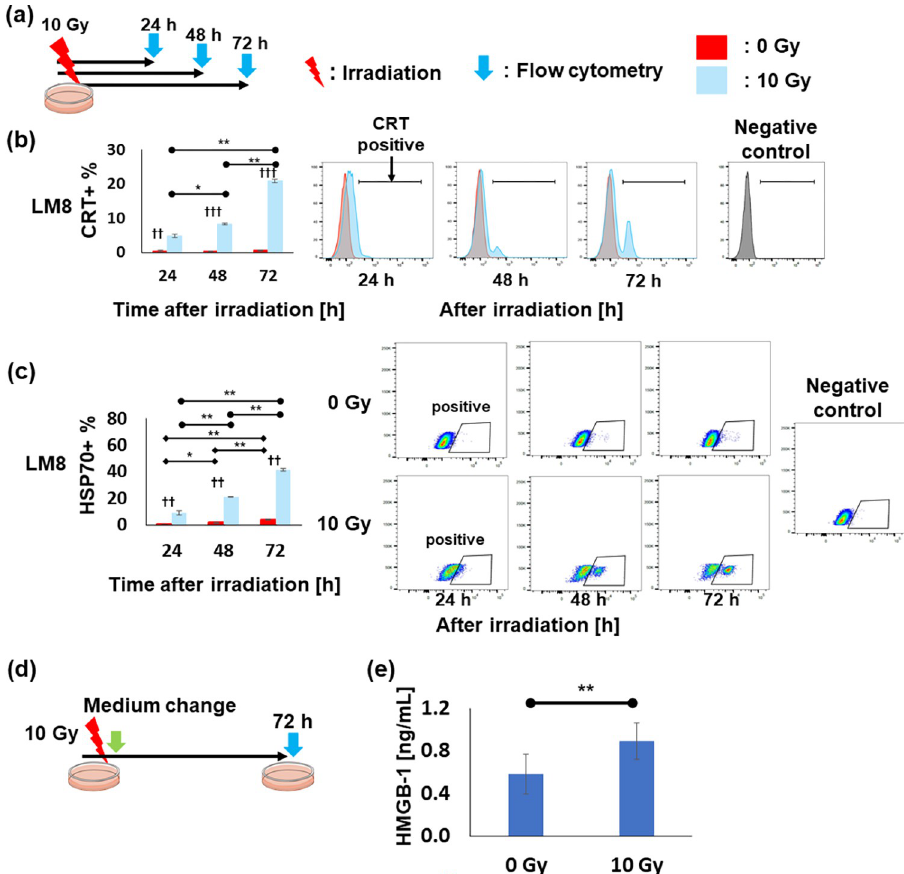
Fig 1. DAMPs expression and release by 10 Gy irradiation at various time points. (a) A scheme of CRT and HSP70 expression analysis. (b) Proportions of translocated CRT on LM8 cell. Panels on the right are representative histograms showing the fluorescent intensity of CRT at each time point. (c) Proportions of HSP70 expressed on LM8 and MG63 cells. Panels on the right are representative histograms showing the fluorescent intensity of HSP70 at each time point. (d) An experimental scheme of HMGB-1 measurement in cell culture supernatants. (e) HMGB-1 concentration in cell culture supernatants of LM8 72 h after 10 Gy irradiation. � p < 0.05, �� p < 0.01, ��� p < 0.001, ���� p < 0.0001; Data represent the mean ± SEM. Significance was evaluated using a two-tailed Student’s t -test. For multiple comparisons, p - values were adjusted using the Bonferroni correction. Abbreviations; DAMPs: damage associated molecular patterns, CRT: calreticulin, HSP70: heat shock protein